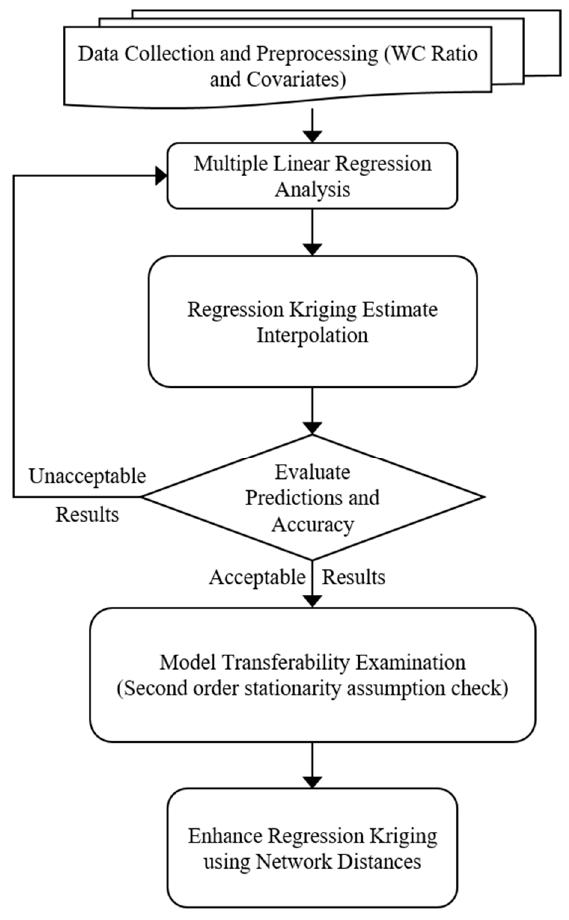
Figure 8. Proposed schematic of the overall workflow.